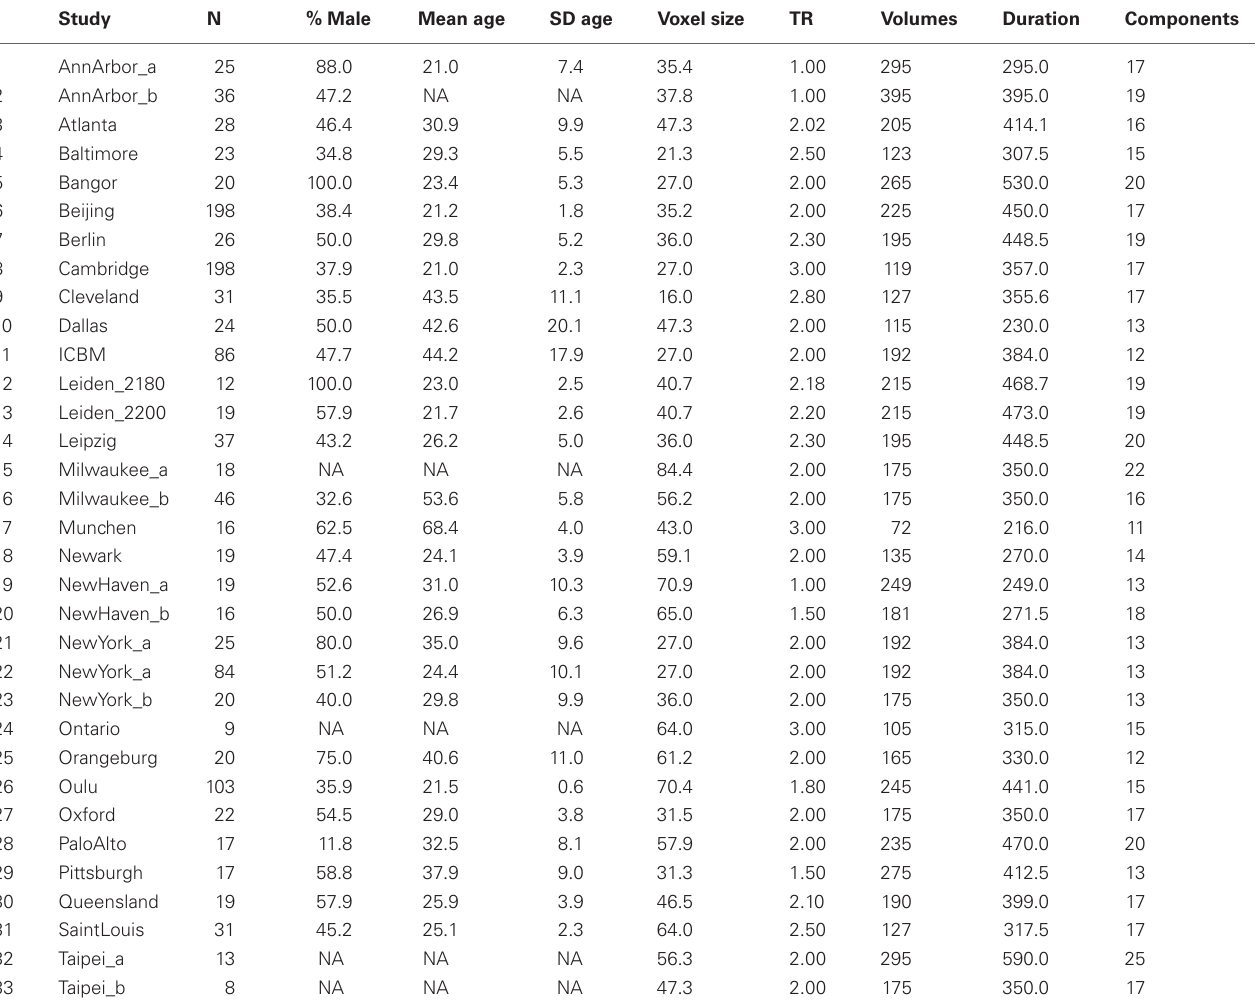
Table 1 | Demographic statistics of the sample